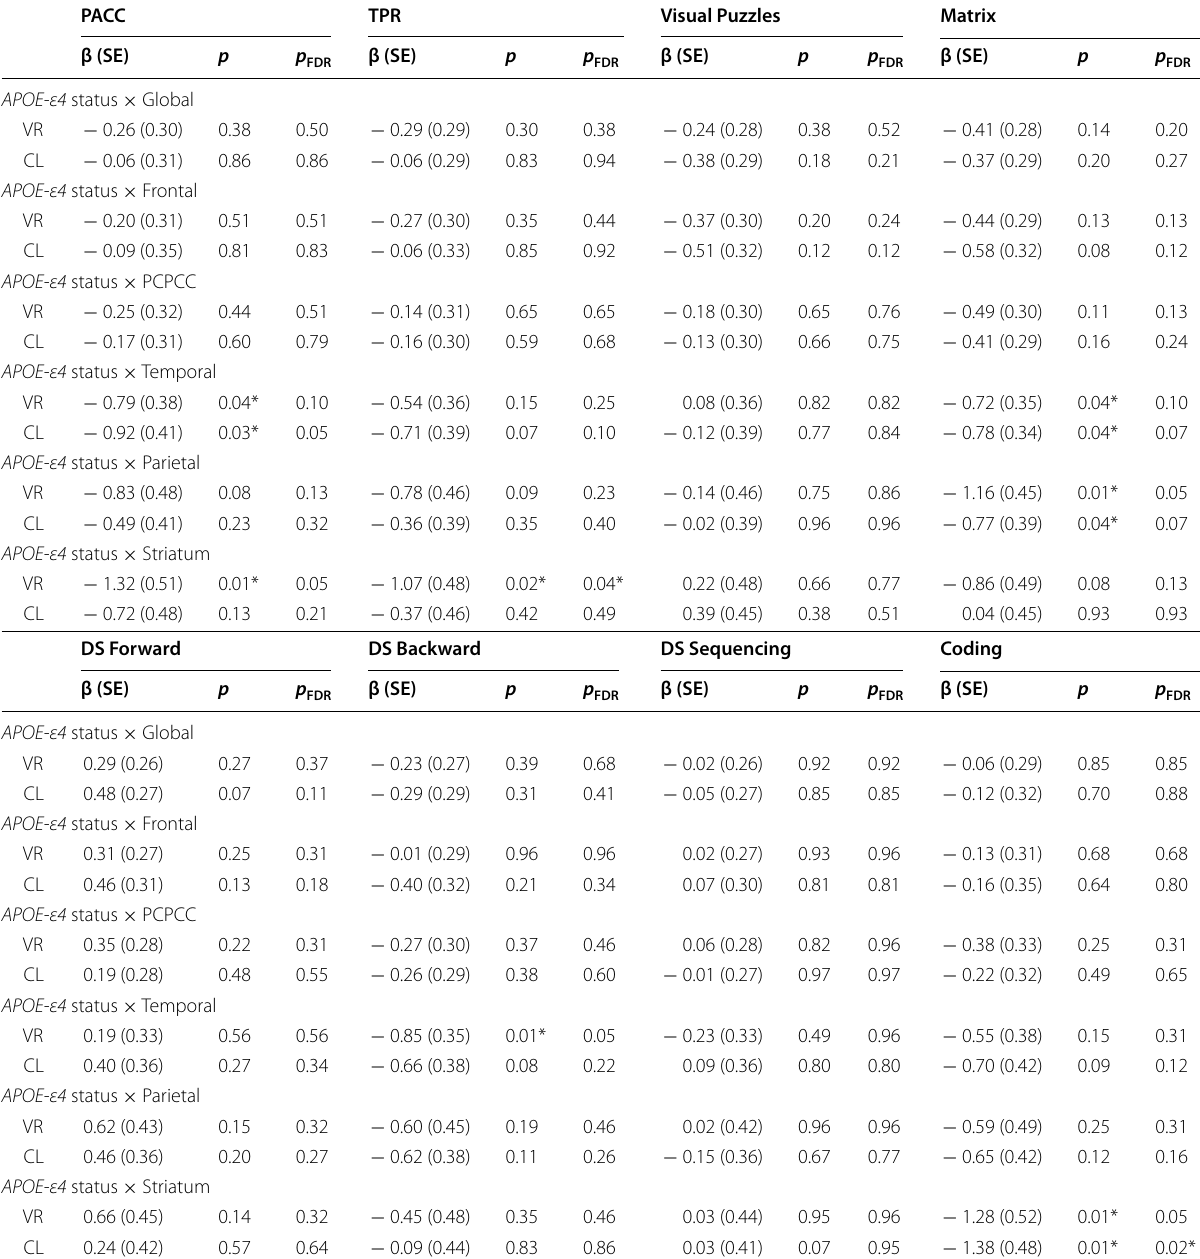
Table 3 Results of linear regression models examining the interaction between regional Aβ accumulation and APOE - ε4 status on cognitive